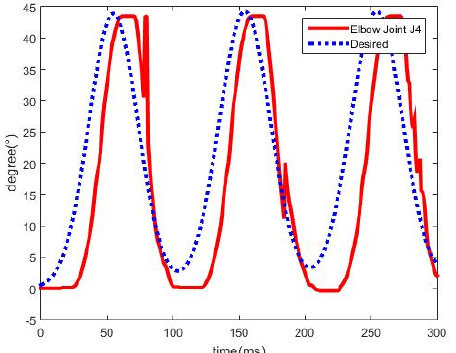
Figure 19. Trajectories of shoulder joint J 2 with tremor occurring.